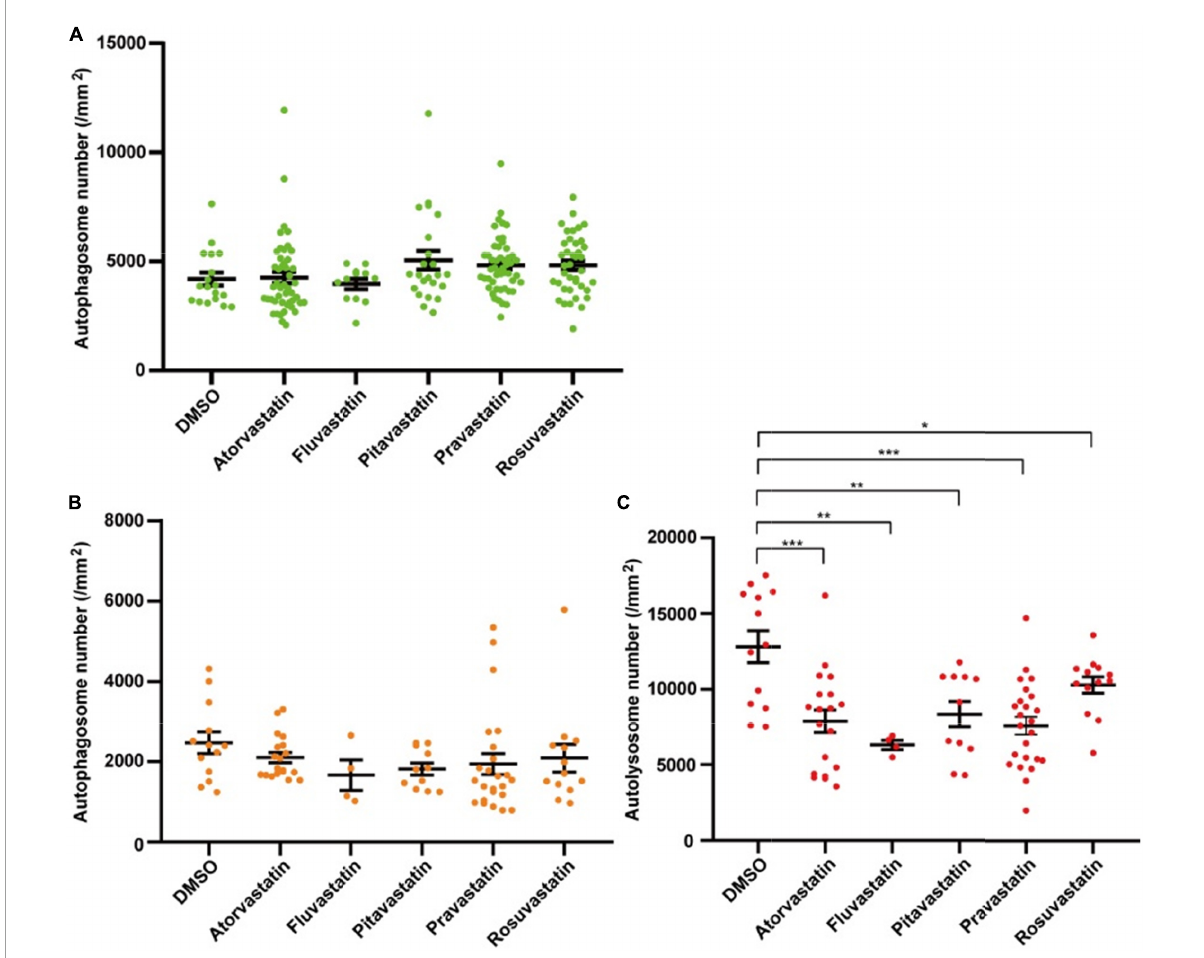
FIGURE6 The densities of autophagosomes and autolysosomes in zebrafish cardiomyocytes are quantified when treated with statins. (A) Quantification of the density of autophagosomes in 3-dpf zebrafish heart of Tg(myl7:EGFP-LC3) line when treated with indicated statins. (B) Quantification of the densities of autophagosomes in 3-dpf zebrafish heart of Tg(myl7:mRFP-EGFP-LC3) line when treated with indicated statins. (C) Quantification of the densities of autolysosomes in 3-dpf zebrafish heart of Tg(myl7:mRFP-EGFP-LC3) line when treated with indicated statins. The data are shown as mean ± s.e.m for each group. n = 13 in the control group, n = 19 in the atorvastatin group, n = 4 in the fluvastatin group, n = 11 in pitavastatin, n = 24 in the pravastatin group, and n = 13 in the rosuvastatin group. * p < 0.05, ** p < 0.01, *** p <